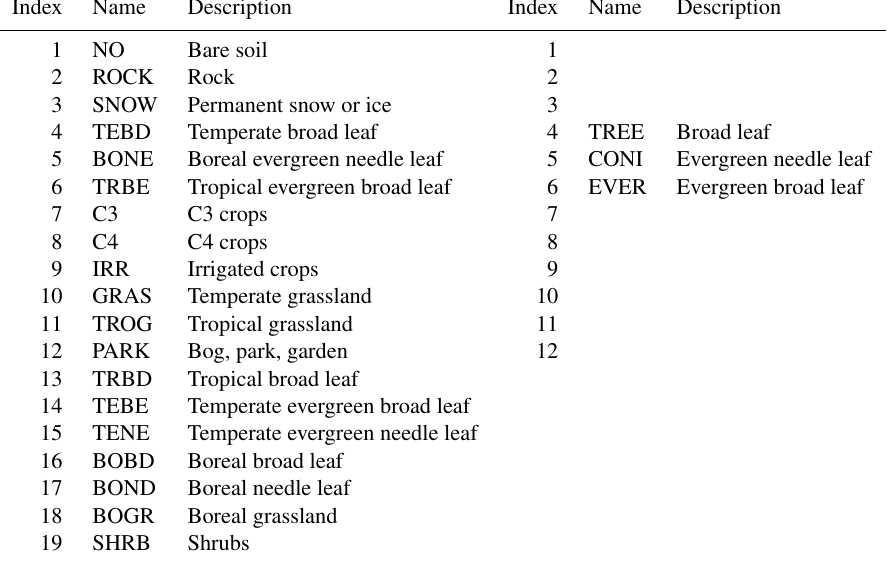
Table 1. Description of the patches for the natural land surface sub-grid tile. The values for the 19-class option are shown in the leftmost three columns, and those for the 12-class option are shown in the rightmost three columns (the name and description are only given if they differ from the 19-class values). MEB can currently be activated for the forest classes: 4–6 (for both the 12- and 19-class options), and